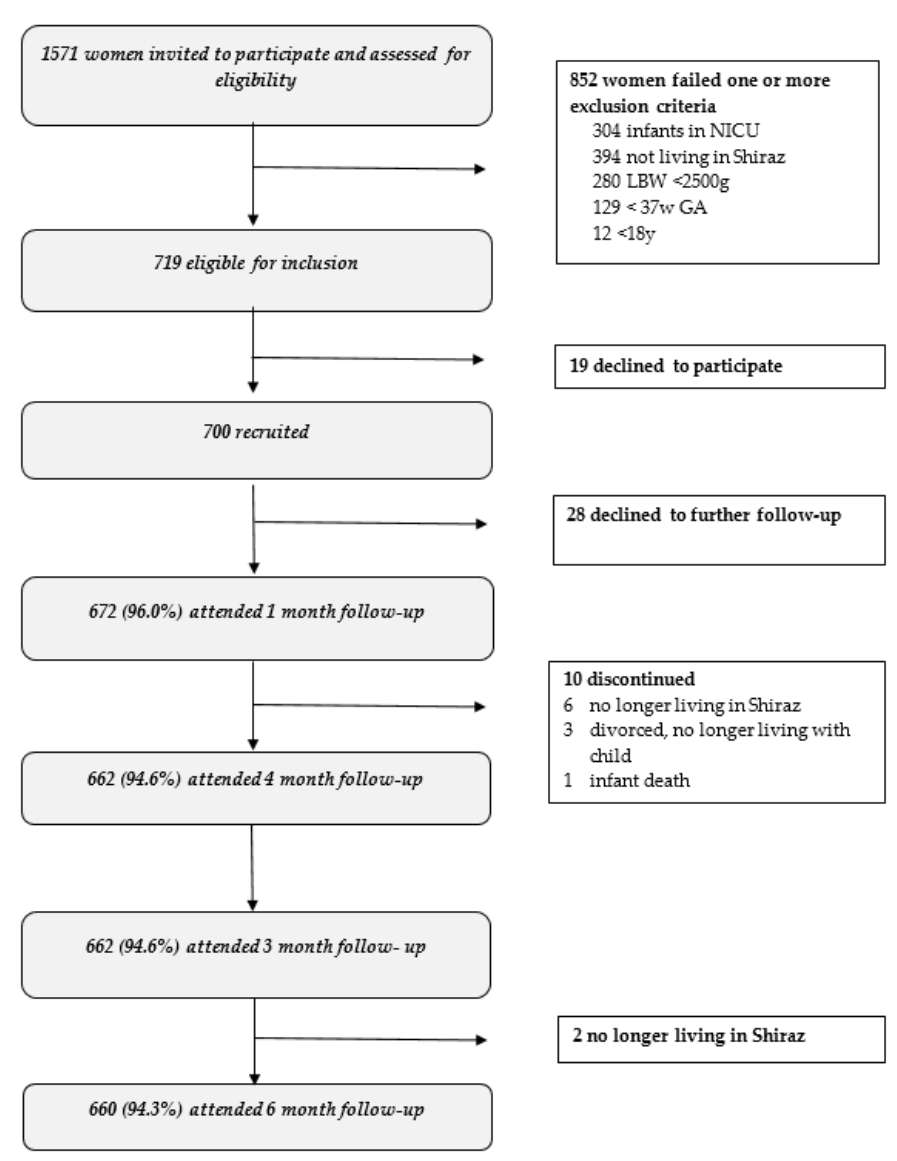
Figure A1. Flow Diagram of Participant Recruitment and Follow-Up.